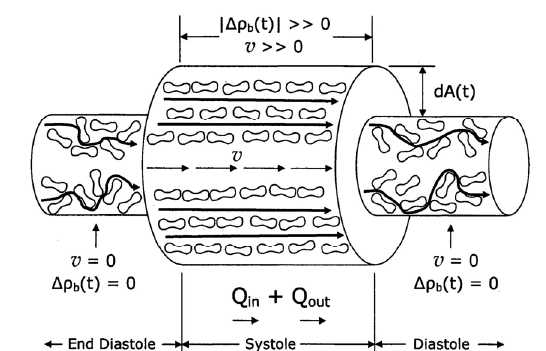
Fig. 3. Behavior of AC as applied to pulsatile blood flow. → = AC flow. v = red cell velocity; ∆ρ b (t) = changing specific resistance of flowing blood.; Q in = flow into aortic segment; Q out = simultaneous flow out of aortic segment; dA(t) = time-dependent change in aortic CSA. From reference